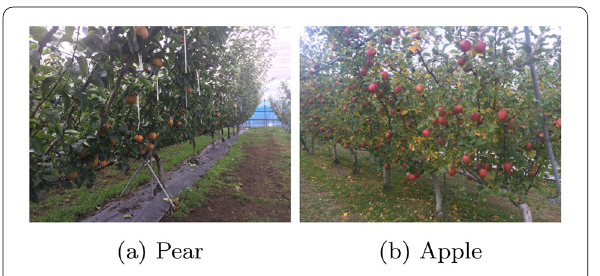
Fig. 12 Result of pear